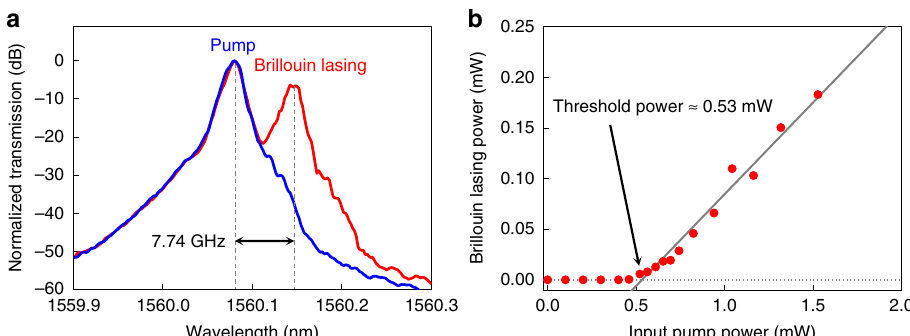
Fig. 3 Brillouin laser with a sub-mW threshold power using a high- Q resonator. a Optical spectra obtained by an optical spectrum analyzer with pump powers below threshold (blue line) and above threshold (red line). The Brillouin shift of 7.74 GHz was measured by an electrical spectrum analyzer. b Input pump power versus Brillouin lasing power. A lasing threshold power of 0.53 mW is obtained by a linear fi tting of the data